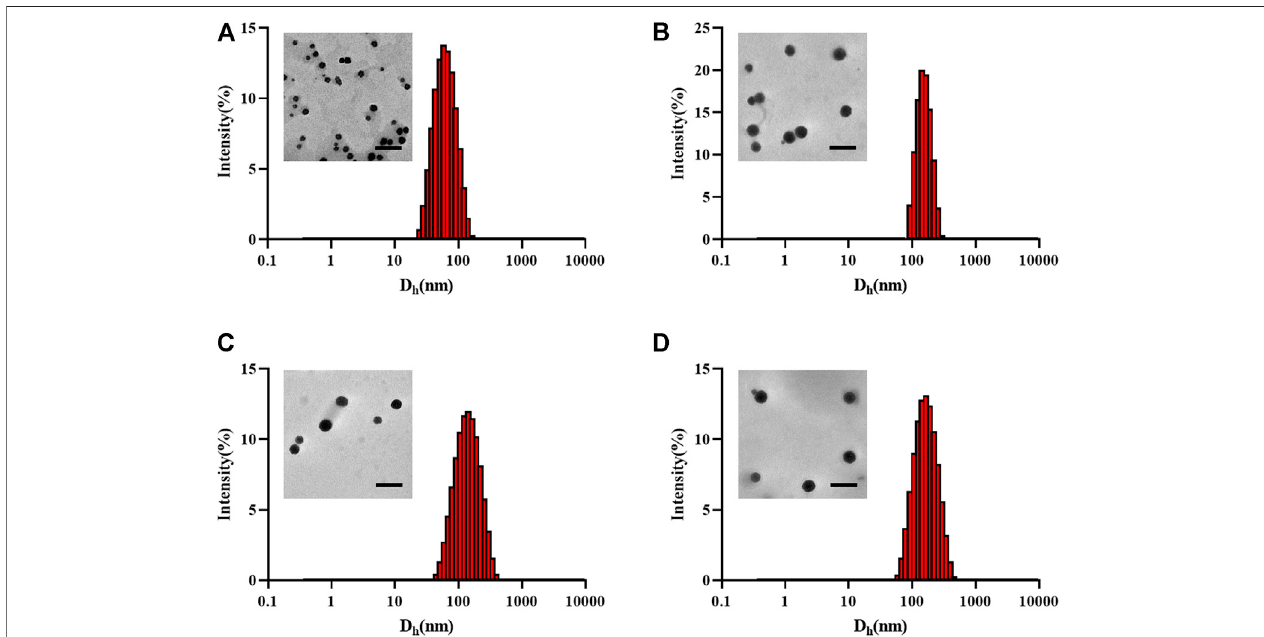
FIGURE 2 | Physical characterization of nanogels. The TEM and hydrodynamic diameter detected by DLS of unloaded nanogel (A) , DOX NG (B) , Ola NG (C) , and DOX/Ola NG (D) . The scale bar is 500 nm.